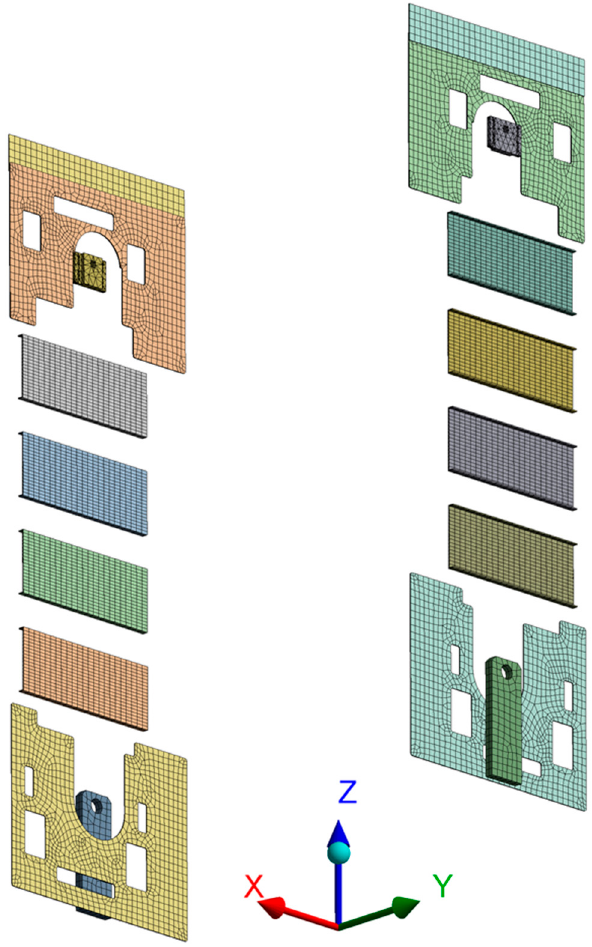
Figure 6. Vibration Sensor Location Candidate.